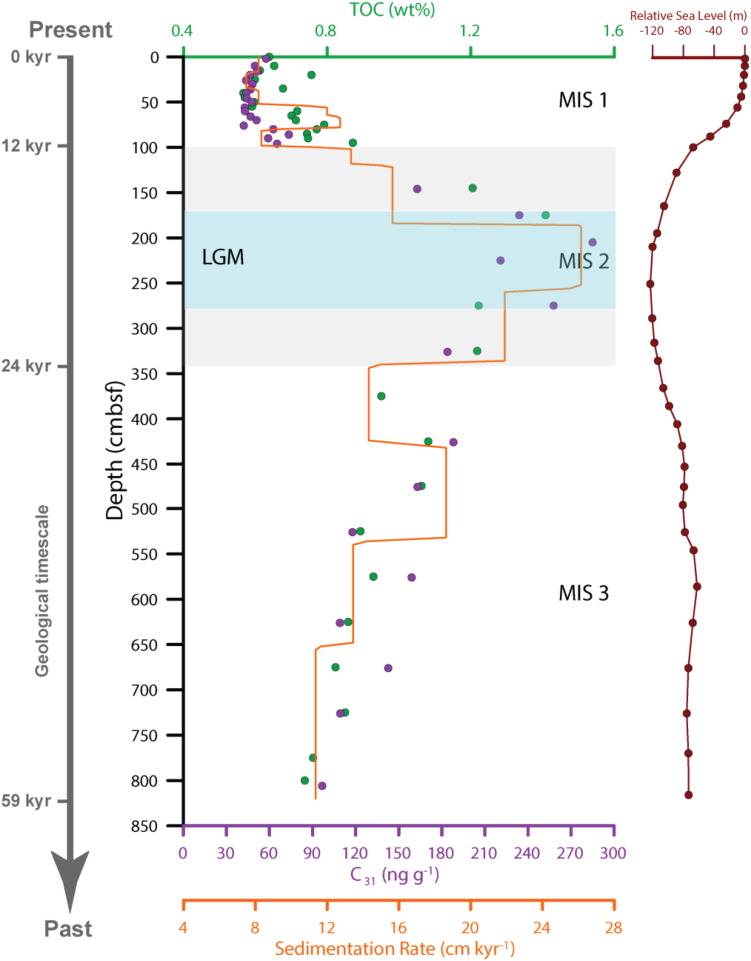
The depth profiles of total organic carbon (TOC), n-alkane C31, and sedimentation rate. The geological timescale (59 kyr-present) is shown on the right. The Relative Seal Level is from Higginson et al. (2003). Samples were assigned to MIS 1, MIS 2, and MIS 3 according to the age model established by (Zhao et al., 2017). LGM, Last Glacial Maximum.